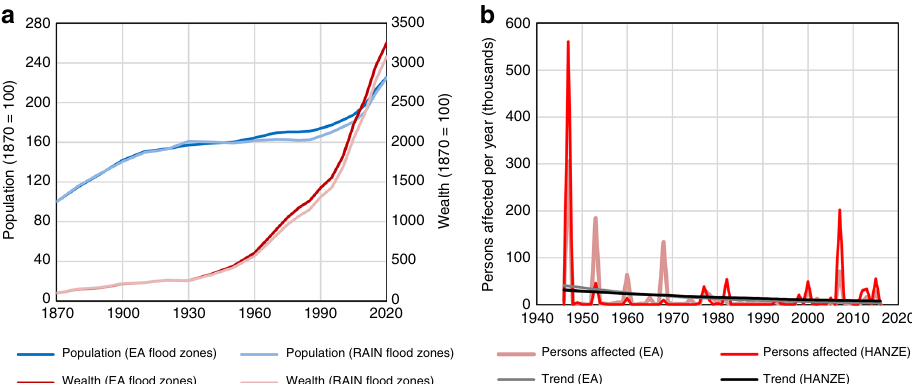
Fig. 7 Validation of fl ood trends. a Trends in population and fi xed assets living within 100-year fl ood hazard zone in England, using Environment Agency (EA) fl ood risk map and RAIN project map used in this study. b estimated persons affected (normalized) in England, compiled by intersecting EA historical fl ood outlines with HANZE-Exposure population grid, and compared with normalized reported persons affected from HANZE-Events. The trends were calculated using Poisson